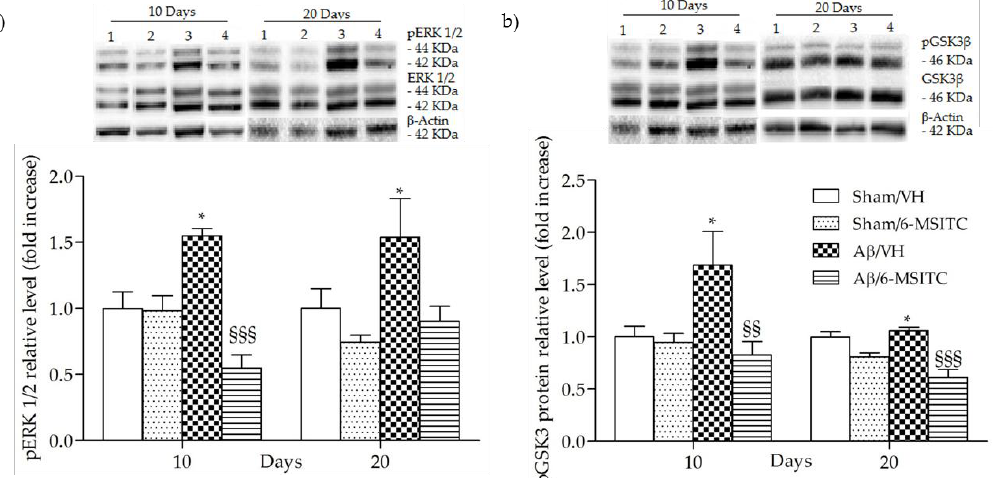
Figure 8. Effects of 6-MSITC (5 mg/kg) on ERK (pERK) and GSK3 β phosphorylations (pGSK3 β ) after A β 1-42 O injection. pERK, pGSK3 β and β -actin were determined 10 and 20 days after A β 1-42 O injection by Western Blotting at 44–42 kDa ( a ) and at 46 kDa ( b ) using respectively total ERK, total GSK3 β and β -actin as loading control. Top: representative images of the protein expression in the hippocampus. Numbers indicate animal groups as follows: 1 Sham/VH, 2 Sham/6-MSITC, 3 A β /VH, 4 A β /6-MSITC. Bottom: quantitative analysis of the Western Blotting results for the pERK and pGSK3 β levels. The graphs show densitometry analysis of the bands appertaining to the protein of interest. Values are expressed as mean of fold increase ± SEM ( n = 10) of each group compared to the Sham/VH group ( a : * p < 0.05 vs. sham groups, §§§ p < 0.001 vs. A β /VH group; b : * p < 0.05 vs. sham groups, §§ p < 0.01 and §§§ p < 0.001 vs. A β /VH group; ANOVA, post hoc test